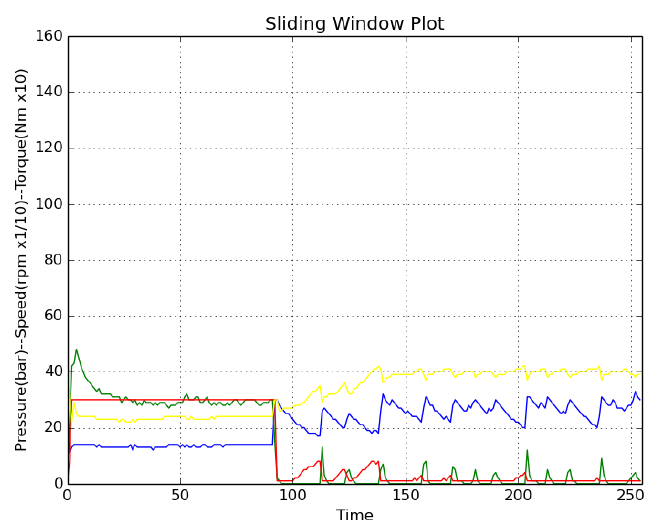
Figure 21. Second experiment of the bi-state